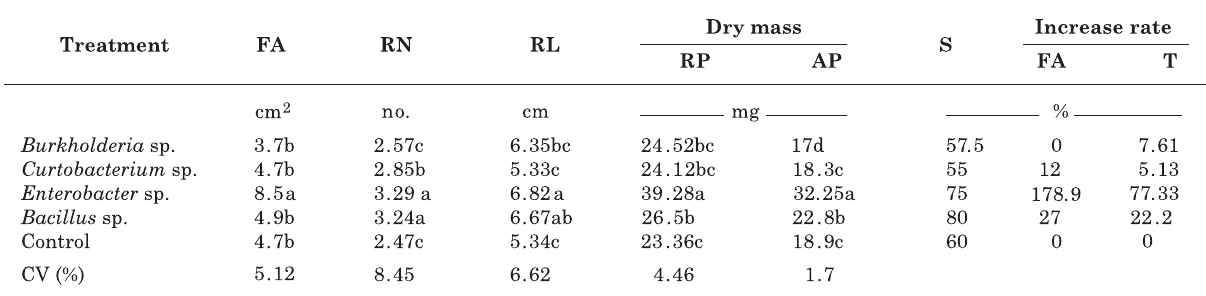
Means followed by the same letter within a column do not differ significantly (p < 0.05) by the Tukey test.